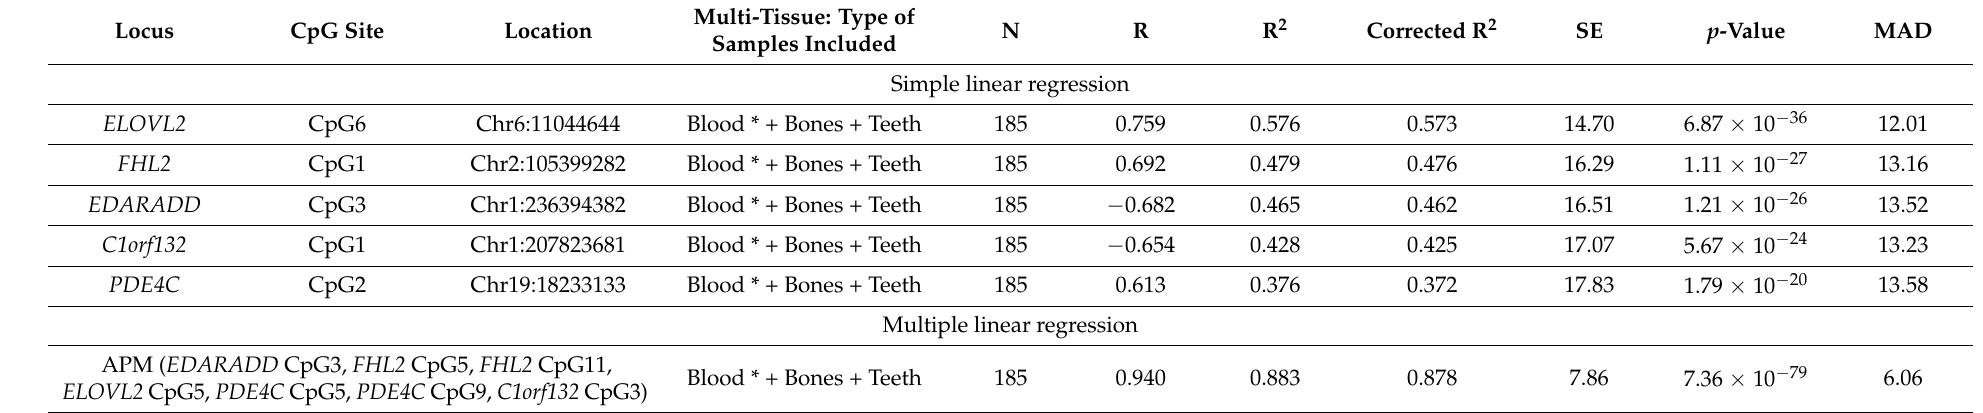
Table 1. Simple and multiple linear regression statistics of the age predictors in ELOVL2, FHL2, EDARADD , PDE4C and C1orf132 genes to test for association between the DNAm levels and chronological age using Sanger sequencing methodology.